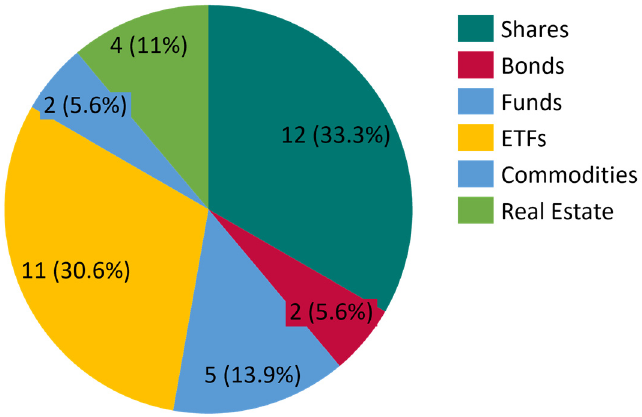
Figure 2. The initial asset composition for the higher-risk portfolio. Table 4. The selection of the six investment products for the testing of the trading